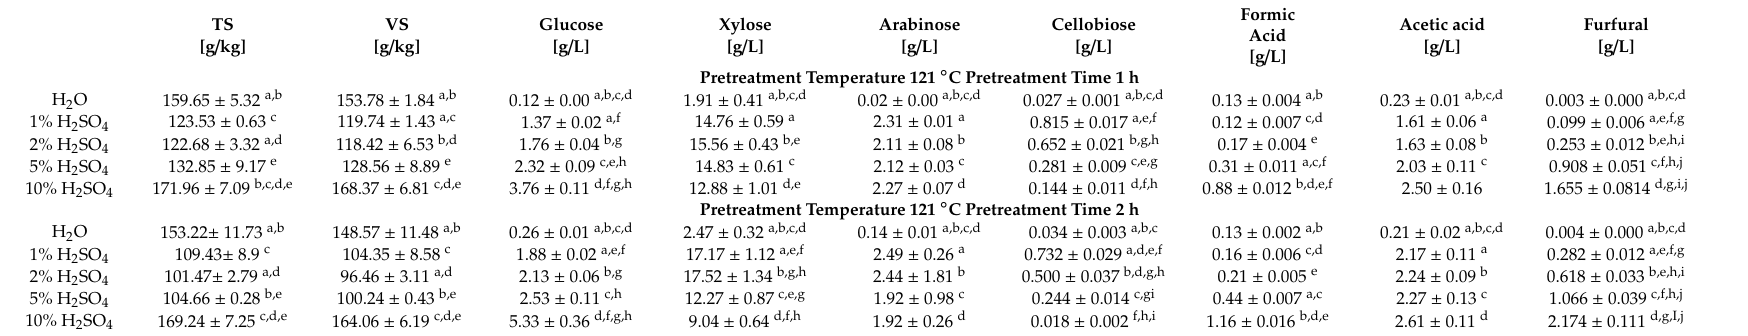
The same lowercase letters in the table row indicate significantly statistical di ff erences ( p < 0.05) (under the same temperature and time conditions: 121 ◦ C and 1 h or 121 ◦ C and 2